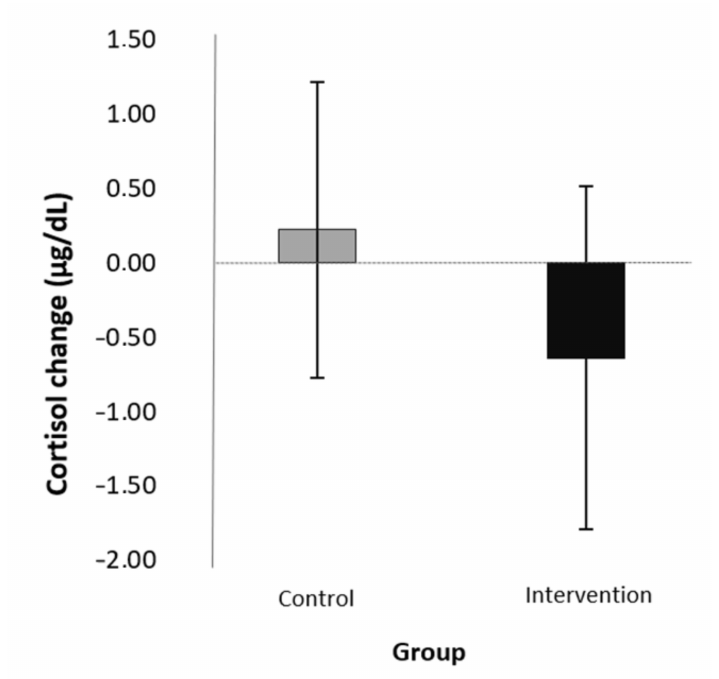
Figure 3. Effects of the intervention (mean of the change scores and SD) on morning cortisol levels from pre-test to September in boys.